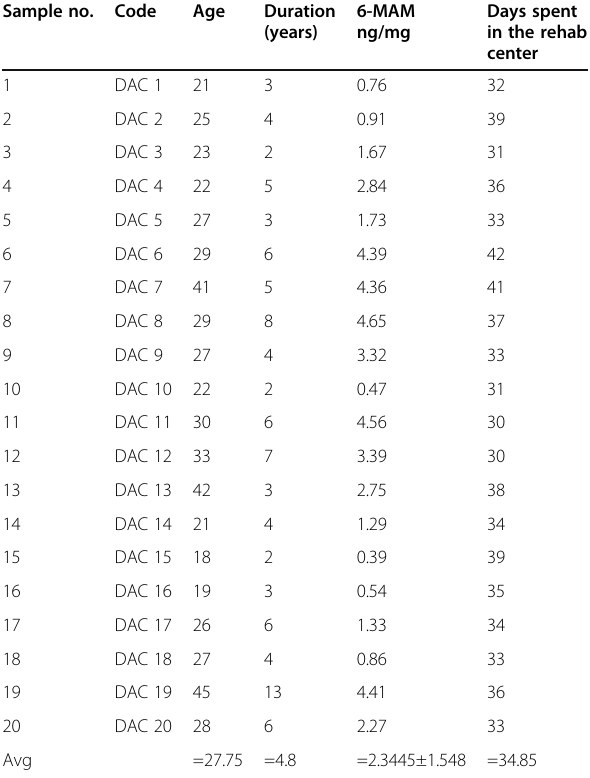
Table 4 6-MAM level in subjects undergoing rehabilitation at the de-addiction center Sample no. Code